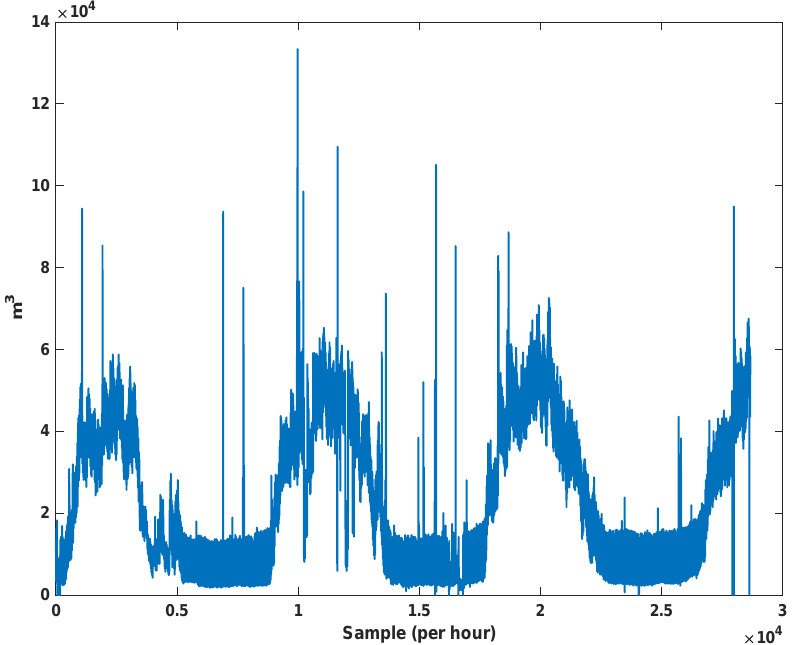
Figure 7. The peak of gas consumption in per hour. The diagrams of the consumption lines in the Ilam CGS station are examined below.